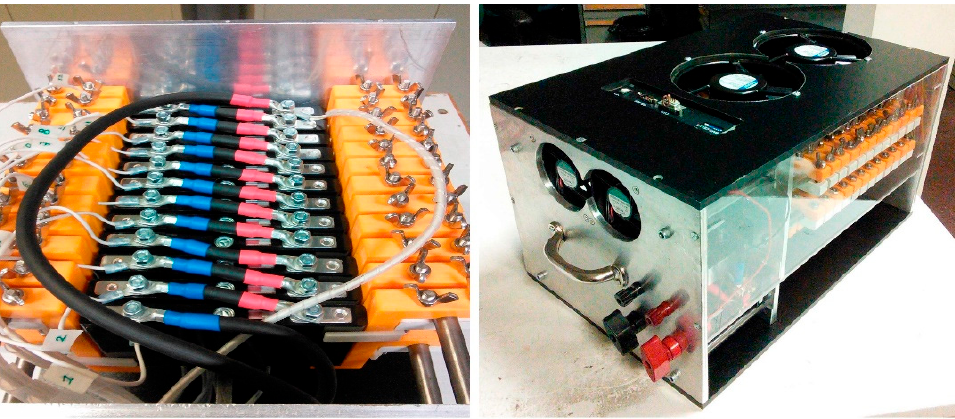
Figure 17. Experimental configuration graphs of the LIC’s air cooling system, reproduced with permission from [155]. Copyright 2019, Elsevier.